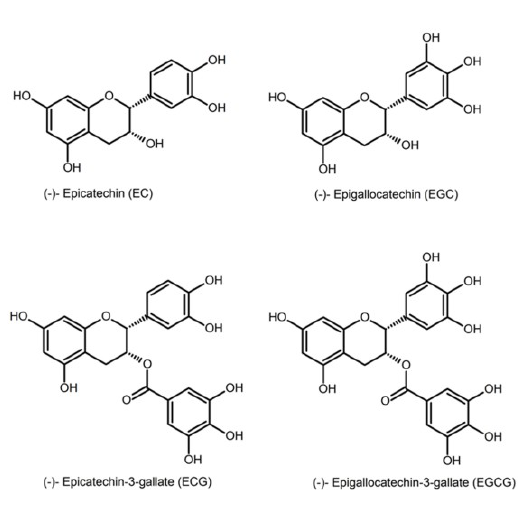
Figure 1. Different catechins found in